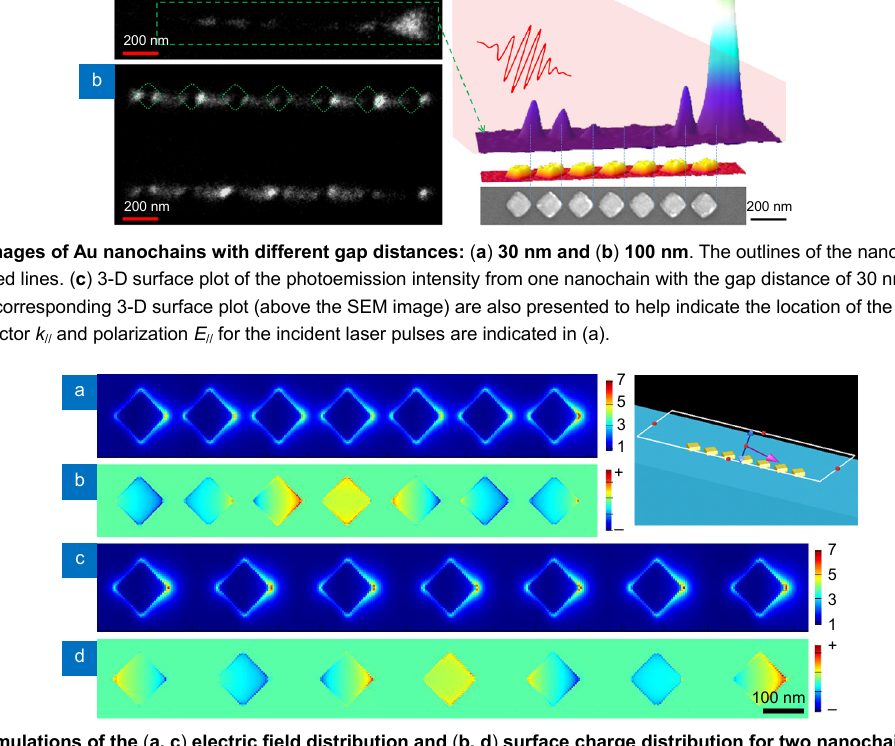
Fig. 5 | FDTD simulations of the ( a, c ) electric field distribution and ( b, d ) surface charge distribution for two nanochains with differ- ent gap distances: 30 nm ( a, b ) and 100 nm ( c, d ). The inset shows a sketch of the light irradiation (the blue and red arrows present the polarization and the wavelength vector of the incident light,